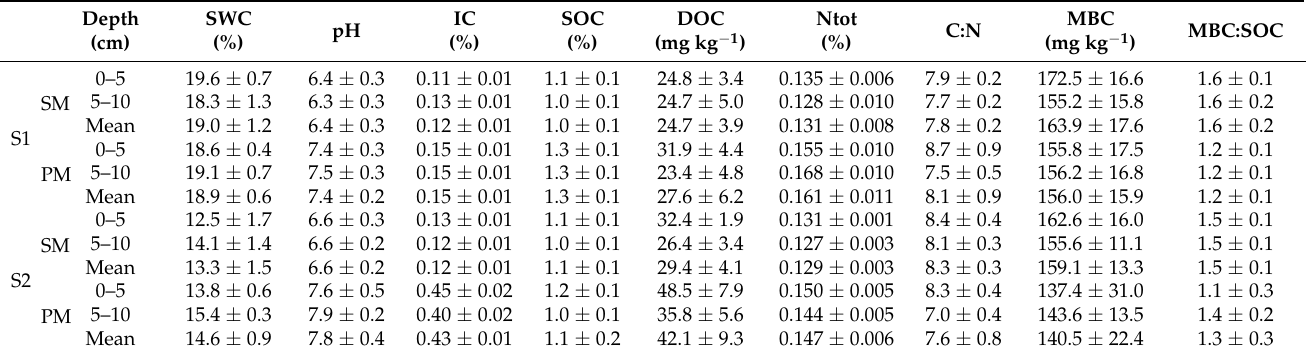
Table 1. Physicochemical and microbial characterization corresponding to soil samples collected in S1 and S2, from straw (SM) and plastic mulching (PM) systems.